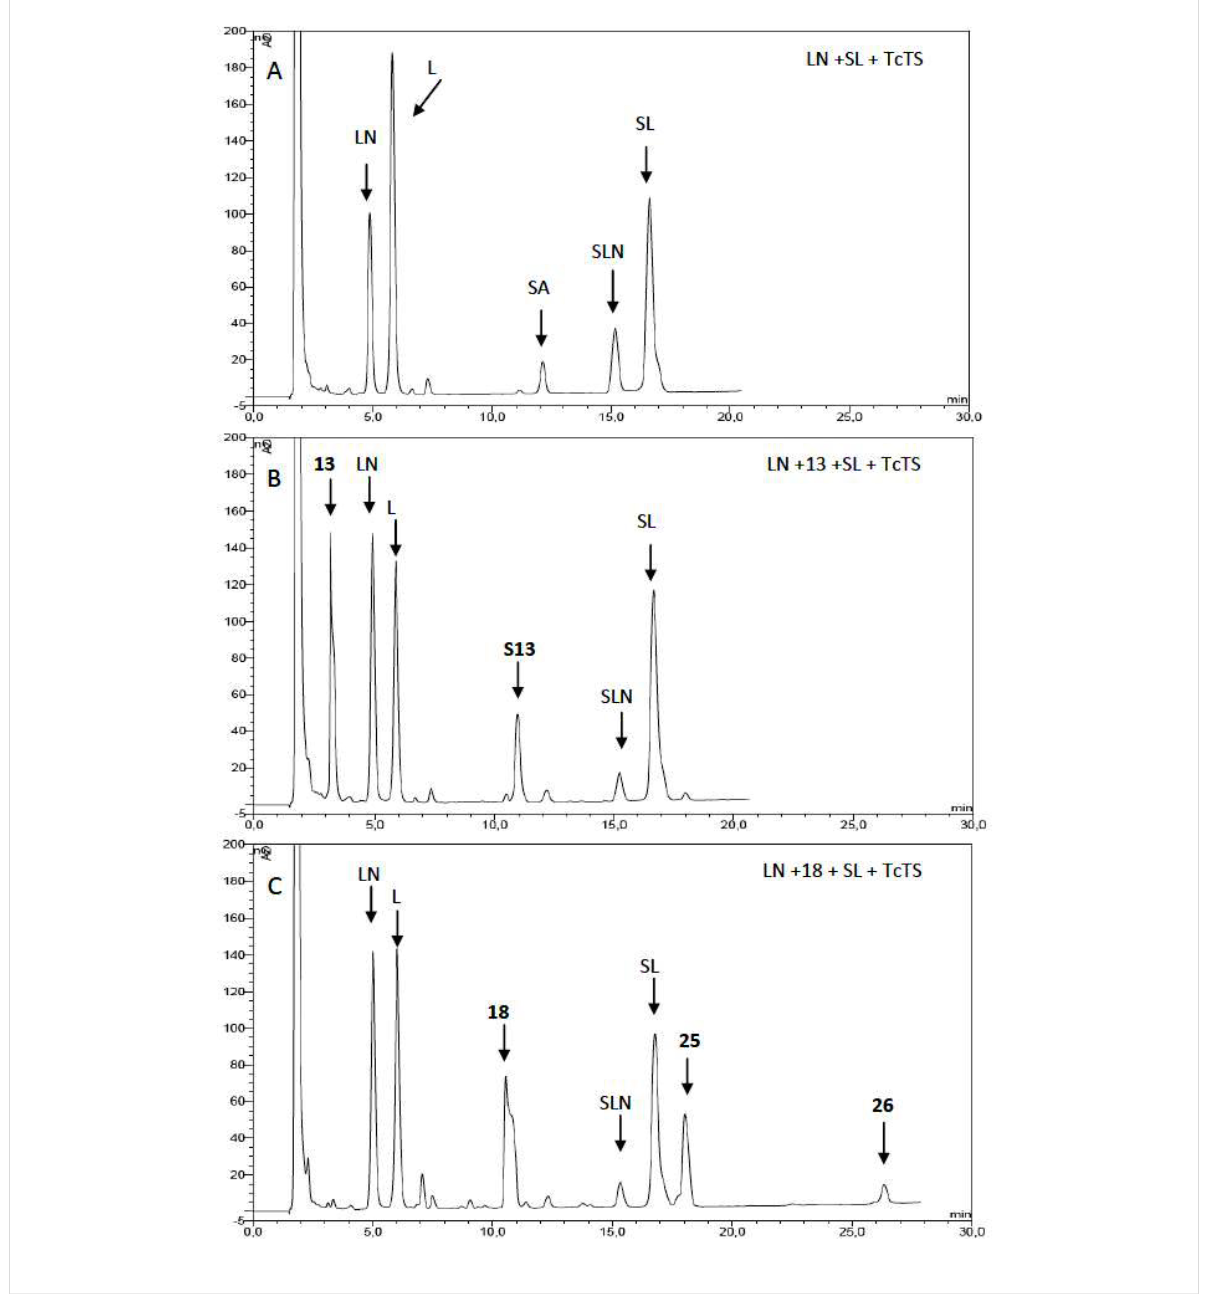
Figure 2: Inhibition of sialylation of LN by compounds 13 and 18 . A: N -acetyllactosamine (LN, 1 mM), 3’-sialyllactose (SL, 1 mM) and TcTS were incu- bated for 15 min at 25 °C. B: The same as A, in the presence of 13 (1 mM) as inhibitor. C: The same as A, in the presence of 18 (1 mM) as inhibitor. The incubation mixtures were analyzed by HPAEC using a CarboPac PA-10 ion exchange analytical column eluted with a linear gradient over 30 min from 20 to 200 mM NaAcO in 100 mM NaOH at a flow rate of 0.9 mL/min. L: lactose; SA: sialic acid; SLN: sialyl N -acetyllactosamine; S13 : monosialyl compound 13